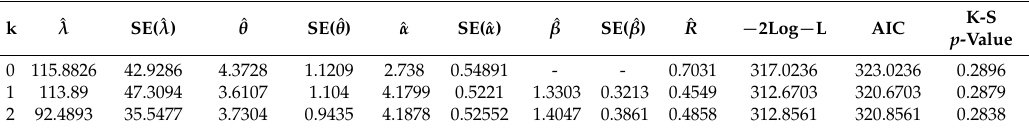
Table 3. Maximum likelihood estimators (MLEs), standard errors (SE), Likelihood, Akaike information criterions (AIC) and K-S P-value